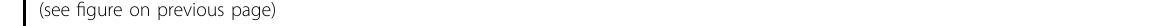
Fig. 4 Dynamic changes in autophagy in a SAKI cell model. HK-2 cells were treated with different concentrations of LPS (2, 4, 8 and 12 h with 10 μ g/ml). A Autophagy increased in a time-dependent manner following LPS challenge, peaked at 8 h and then gradually decreased. HK-2 cells were infected with an adenovirus expressing mRFP-GFP-LC3 (magni fi cation ×630 and scale bar = 20 μ m). B Mean numbers of autophagosomes (yellow dots per cell in merged images) and autolysosomes (red dots per cell in merged images) were calculated in 20 randomly selected cells ( n = 20). C The percentage of autolysosomes (free red spots/(yellow spots + free red spots) per cell) was calculated in 20 randomly selected cells to determine autophagic fl ux ( n = 20). D – G Representative western blots and densitometric analysis of Beclin1, LC3 II and SQSTM1 protein expression ( n = 6). The data are presented as the mean ± SD. * p < 0.05, ** p < 0.01 and *** p < 0.001 vs the 0-h group. H Autophagic fl ux determination and analysis: HK-2 cells were infected with an adenovirus expressing mRFP-GFP-LC3 (magni fi cation ×630 and scale bar = 20 μ m). I Mean numbers of autophagosomes (yellow dots per cell in merged images) and autolysosomes (red dots per cell in merged images) was calculated in 20 randomly selected cells ( n = 20). J The percentage of autolysosomes (free red spots/(yellow spots + free red spots) per cell) were calculated in 20 randomly selected cells to determine autophagic fl ux ( n = 20). SIRT1 activation or inhibition was performed by pretreatment with SRT1720 or EX527 for 2 h, respectively. Samples were collected 12 h after LPS stimulation. The data are presented as the mean ± SD. *** p < 0.001 vs the control group, ### p < 0.001 vs the vehicle + LPS group. K – N Representative western blots and densitometric analysis of the autophagy-related proteins Beclin1, LC3 II and SQSTM1 proteins ( n = 6). The data are presented as the mean ± SD. ** p < 0.01 and *** p < 0.001 vs the control group; ### p < 0.001 vs the LPS group; ††† p < 0.001 vs the GFP-Con + LPS group. SAKI sepsis-induced acute kidney injury, LPS lipopolysaccharide, SQSTM1 sequestosome 1, SIRT1 silent mating-type information regulation 2 homologue-1, GAPDH glyceraldehyde 3-phosphate